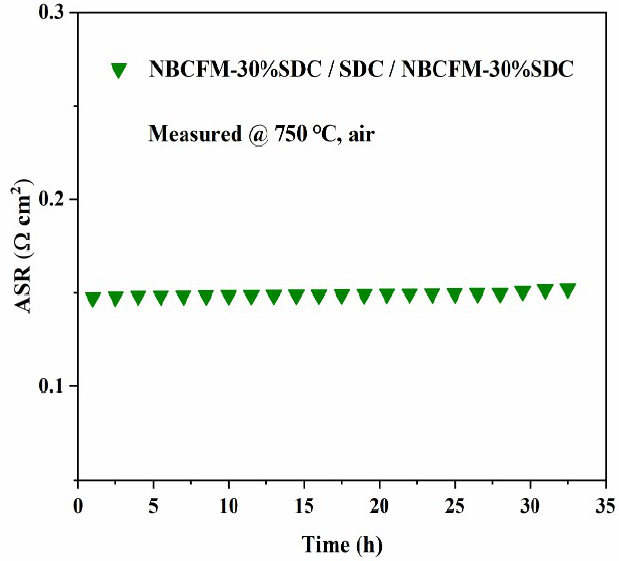
Figure 8. Short-term stability of a symmetric cell at 750 ◦ C in